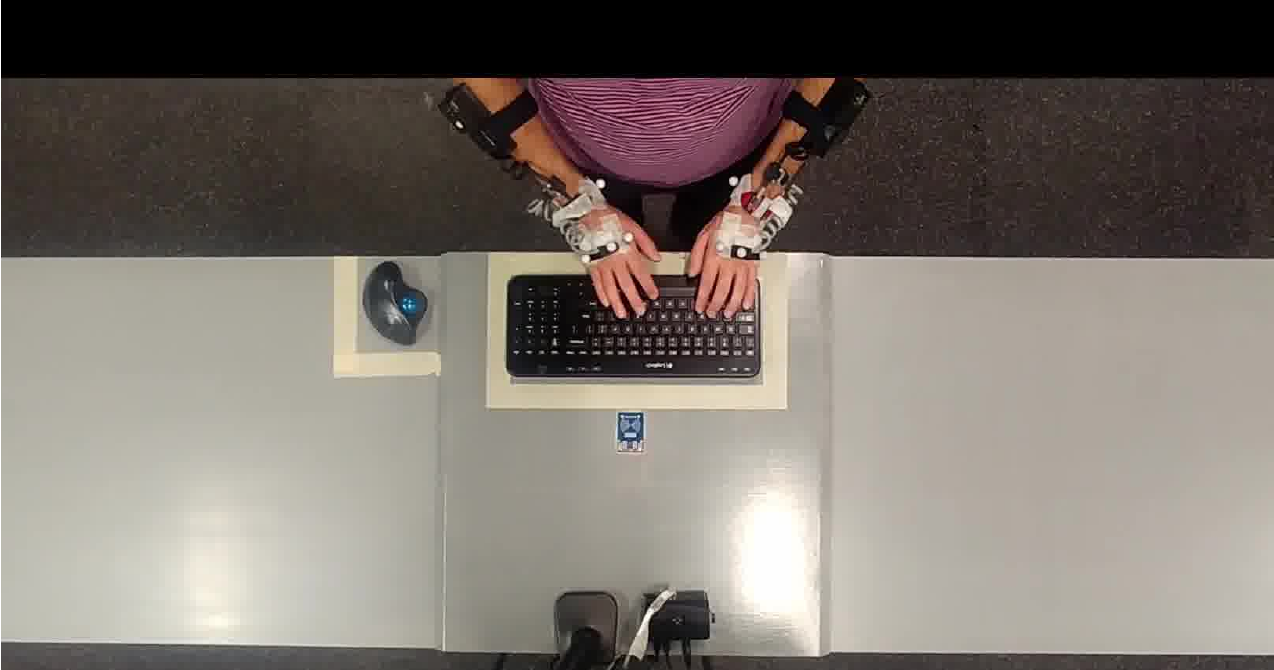
Figure 4. Typing task, showing participant orientation for the 3-minute typing